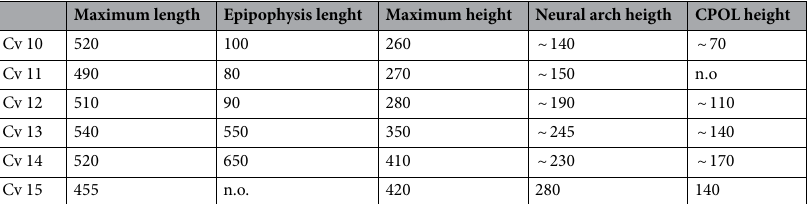
postzygodiapophyseal laminae (PODL) and posterior centrodiapophyseal laminae (PCDL). The cervical ribs, in turn, are present (although not complete) in all elements, except in the 12th. The inclination of the postzygapophyses of the preserved cervical vertebrae shows some differences, with the last preserved element being more ventrolaterally directed, as observed in the posterior cervical vertebrae of other sauropods (e.g. 78 ). The articulation surfaces of the postzygapophyses can only be observed in the last preserved cervical element, where they are flattened. The postzygapophyses have a stout centrodiapophyseal lamina (CPOL) as in Euhelopus and Yongjinglong 4 . The postzygodiapophyseal lamina (PODL) is elongated and thick, being proportionally more elongated in the new taxon compared to Erketu , Euhelopus and Qiaowanlong . Silutitan differs from Erketu and Qiaowanlong by showing a ventrolaterally bifurcated PODL, a feature previously discussed by Moore et al. 47 in Euhelopus , Klamelisaurus and several “core Mamenchisaurus -like taxa”. However, in Euhelopus and Klamelisaurus the ventrolaterally bifurcated PODL is observed solely on the posterior-most cervical vertebrae, while in Silutitan this feature is observed in the 9th, 10th, 12th, 14th and 15th element (Fig. 3), being less developed in the anterior-most cervical vertebrae. This persistence of the ventrally bifid PODL along most of the cervical vertebrae of Silutitan is considered an autapomorphy since, to our knowledge, this feature is not observed in any other taxa. Silutitan also presents a variation of the development of the ventrally bifid PODL along the cervical vertebrae sequence. On the anterior-most vertebrae preserved, the bifurcation of this lamina is restricted more anteriorly and positioned almost exclusively ventrally; but on the posterior-most cervical, the bifurcation extends in length and becomes more ventrolaterally than the other cervical vertebrae. We regard the development of the ventro- laterally bifurcated PODL through the cervical series unique to Silutitan . Silutitan presents, as other sauropods, developed epipophyses on the dorsal surface of the postzygapophyses, but unlikelythe euhelopodids Euhelopus zdanskyi 7 , Erketu ellisoni 28,29 , Phuwiangosaurus 23 and Qiaowanlonq 2 , the epipophyses of Silutitan are elongated . The neural spines are well preserved in cervical 14 and 15, showing that they are low and reduced anteroporsteriorly. An incomplete lower jaw of a pterosaur was recovered associated with this specimen (Fig. 3F). Despite its incompleteness, this specimen shows the same anatomy of the sole pterosaur collected in this region, Hamipterus tianshanensis 38 , and is therefore referred to this taxon.